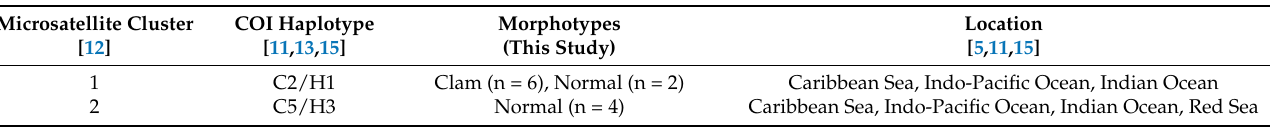
Table 1. Genetic classifications and morphotype diversity of giant barrel sponges (GBSs) of the genus Xestospongia , high- lighting shared haplotypes between clam and normal morphotypes in Barbados based on partial mitochondrial cytochrome oxidase subunit I (COI) gene sequences. GenBank accession numbers for sequences obtained here: